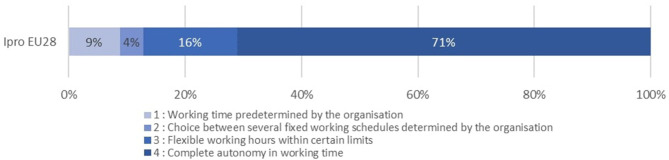
Autonomy in time arrangements.